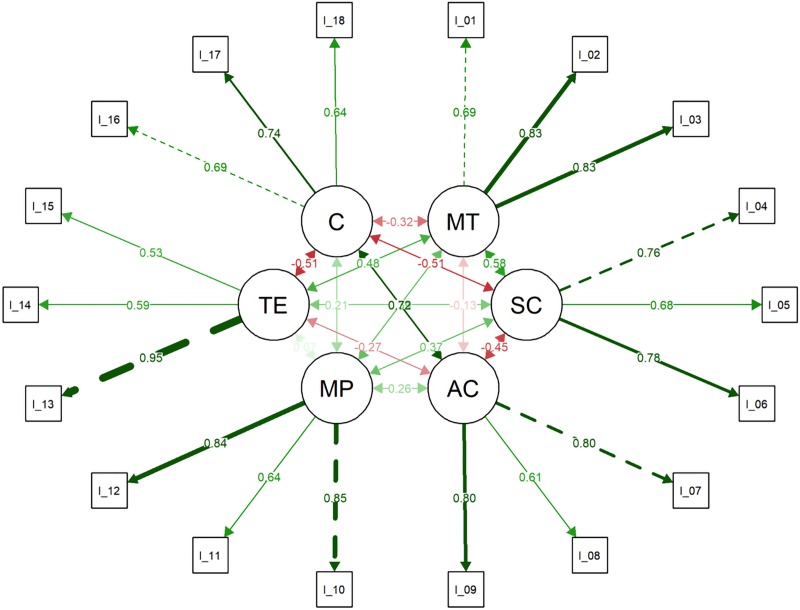
Graphical representation of the confirmatory factor analysis.